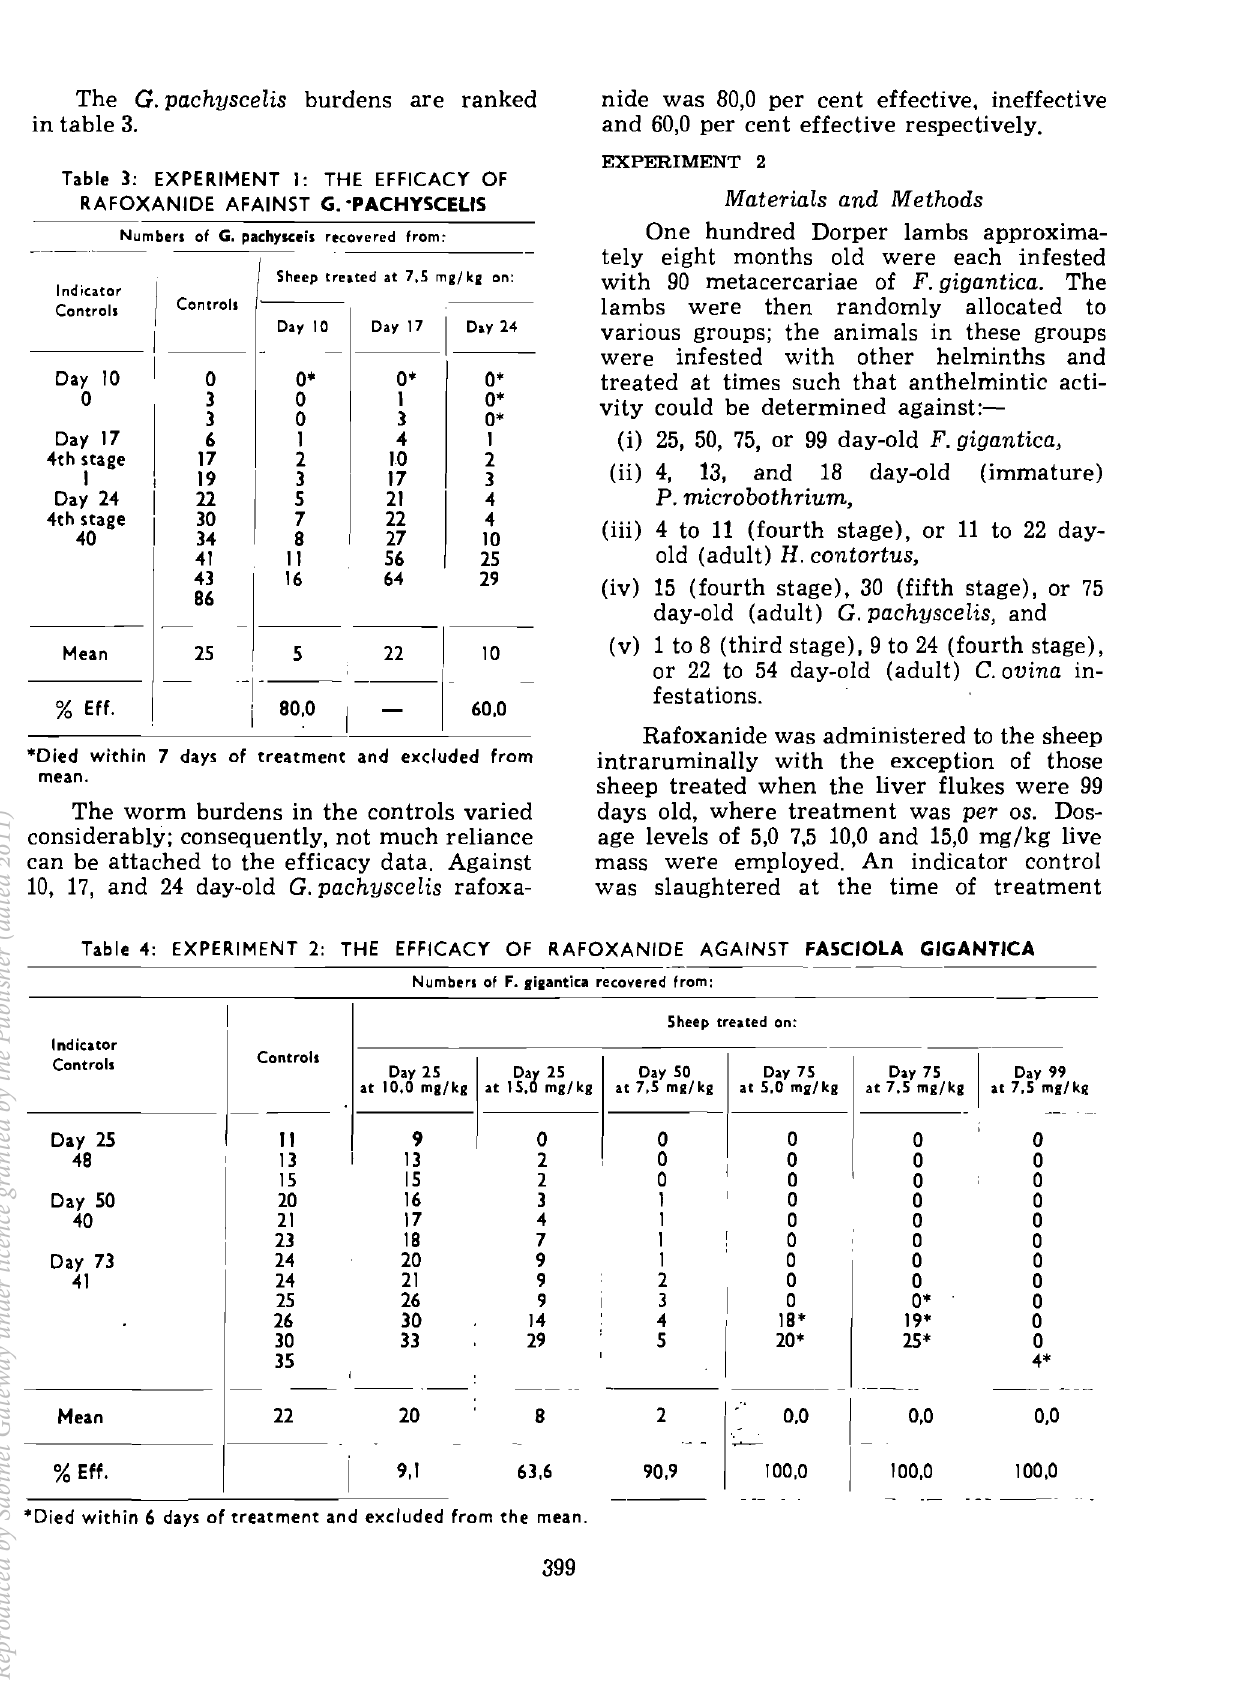
Table 3: EXPERIMENT I: THE EFFICACY OF RAFOXANIOE AFAINST G. 'PACHYSCELIS Numbers of G. pachyscels recovered from: Sheep treated at 7.5 mil kl on: Indicator